Question: How would you classify this visualization?
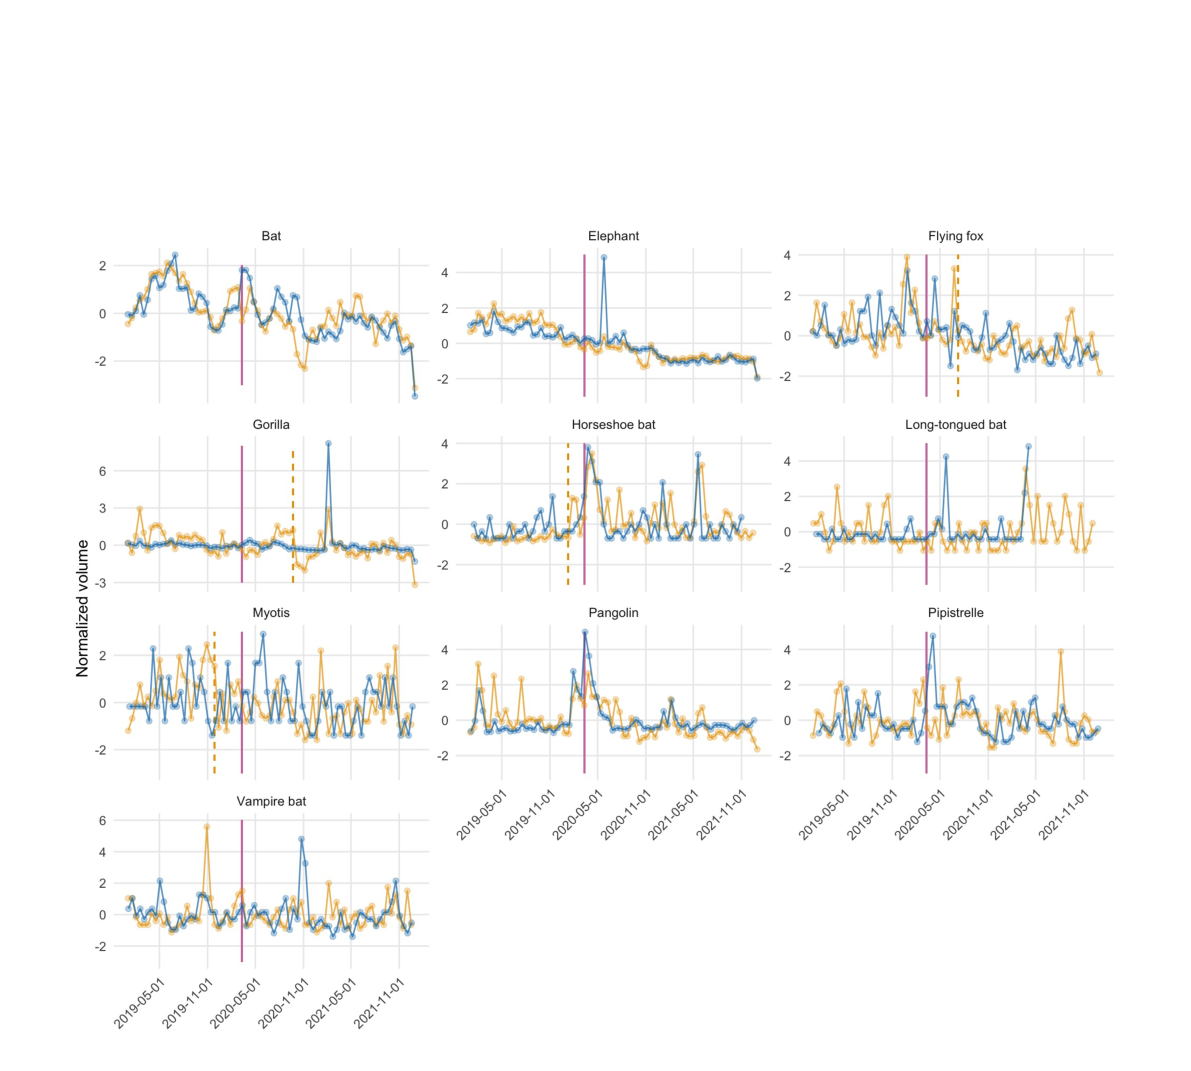
Answer: line